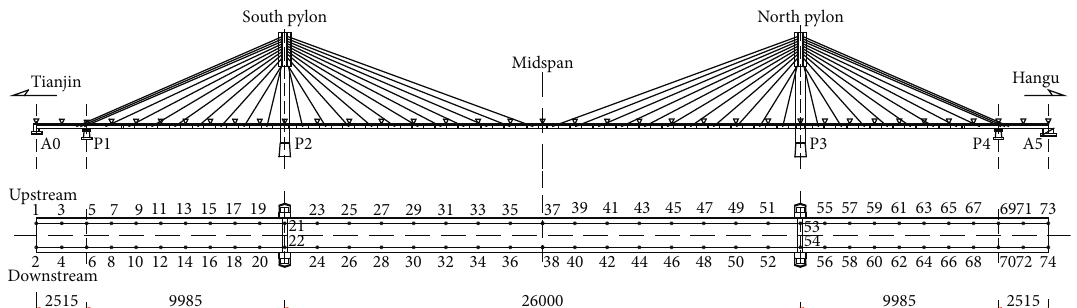
Figure 9: Measurements of bridge deck profile (unit: